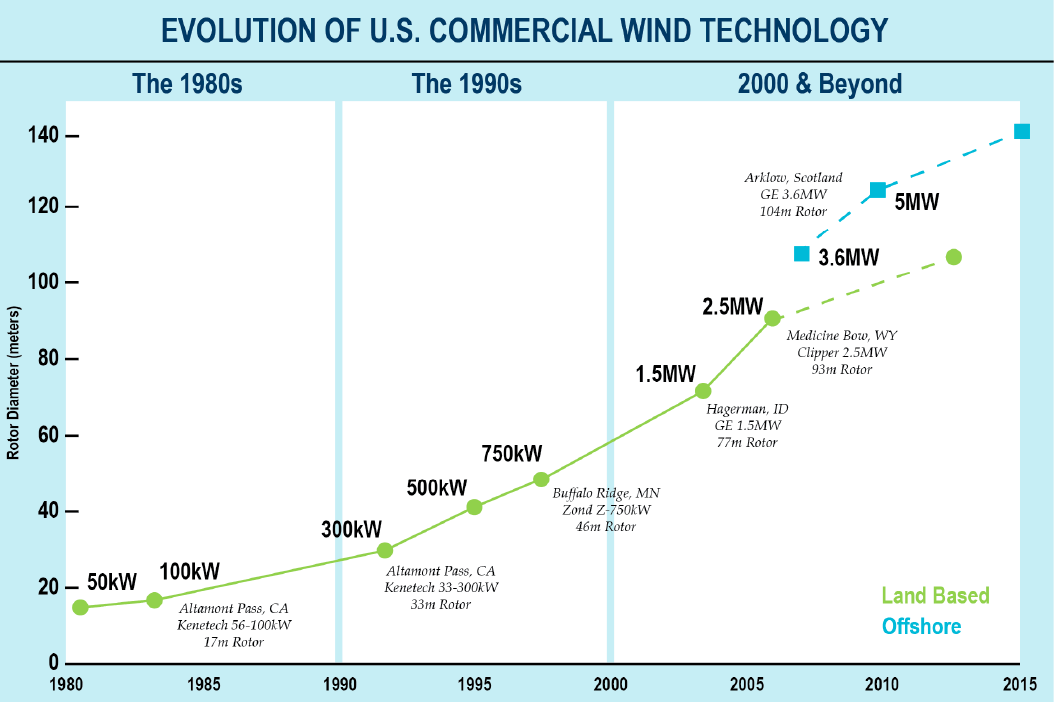
Figure 3. The evolution of U.S. commercial wind technology. Note that rotor diameter increased project capacity over time, with largest rotor diameters being proposed for o ff shore wind projects. Adapted from